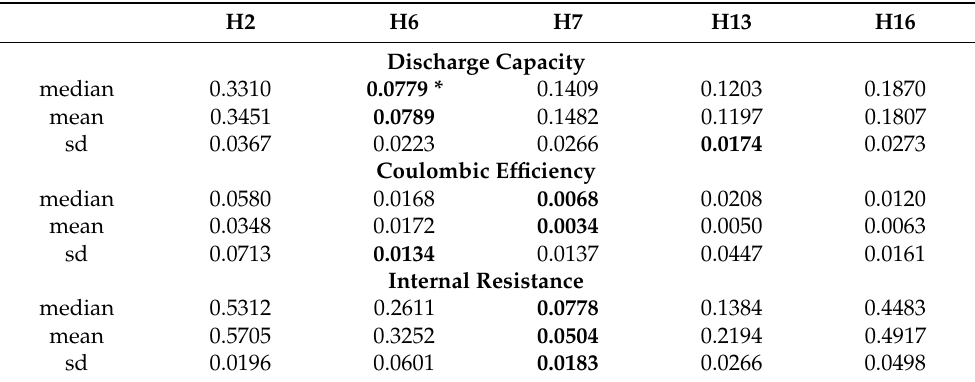
Figure 7. ( a ) Discharge capacities for factor combination H13; ( b ) empirical coefficient of variation (ECV) for the discharge capacity per cycle and for all cycles ( c ) in boxplots. (The purple line highlights the factor combination H13). Table 7. Overview of median, mean and standard deviation for empirical coefficient of